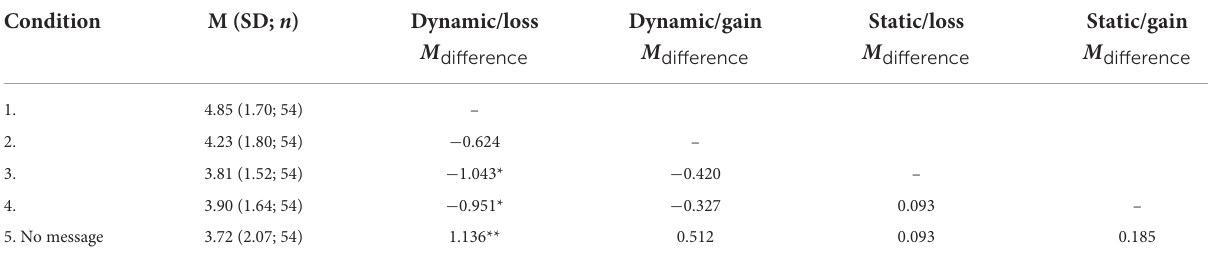
TABLE 3 Descriptive statistics and ANOVA